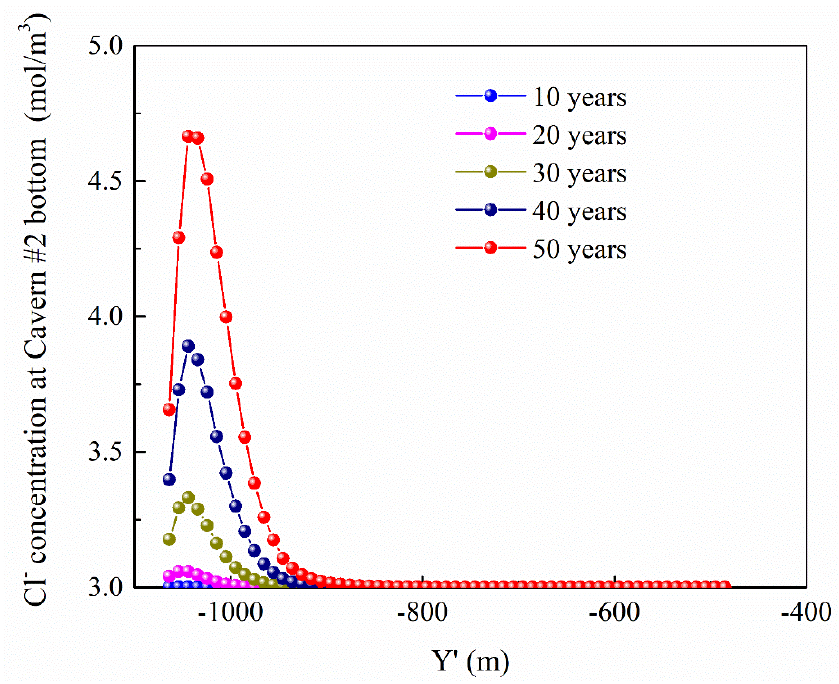
Figure 22. Cl − concentration on the bottom of Cavern #2 during the operation period.